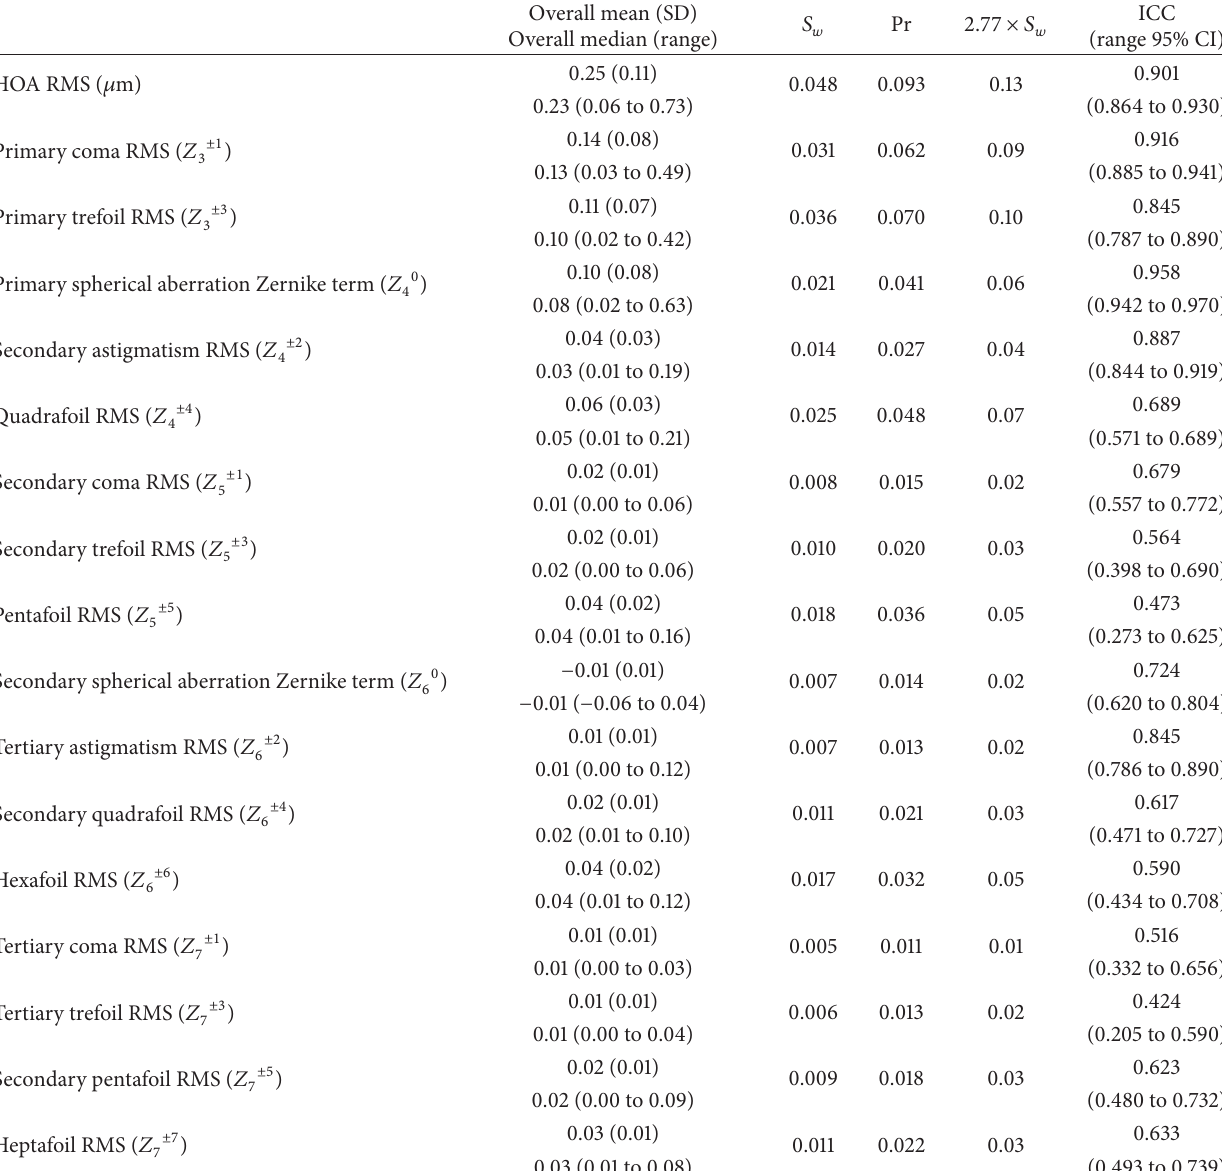
Table 3: Summary of the intrasession repeatability outcomes for the corneal aberrometric measurements obtained by means of the VX120